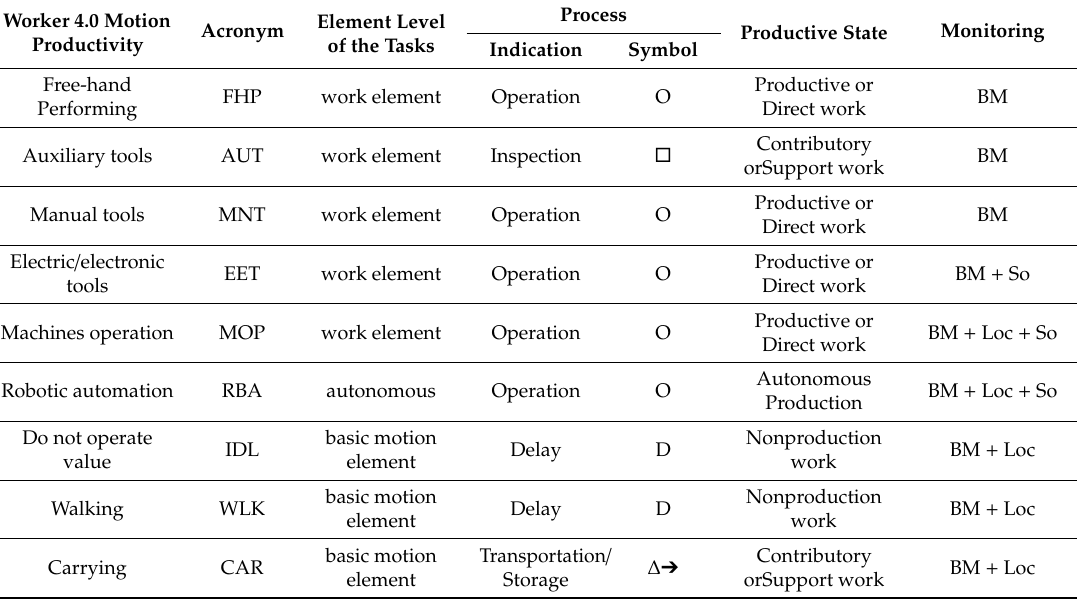
Table 4. Worker 4.0: motion productivity (W4MP) specifications and